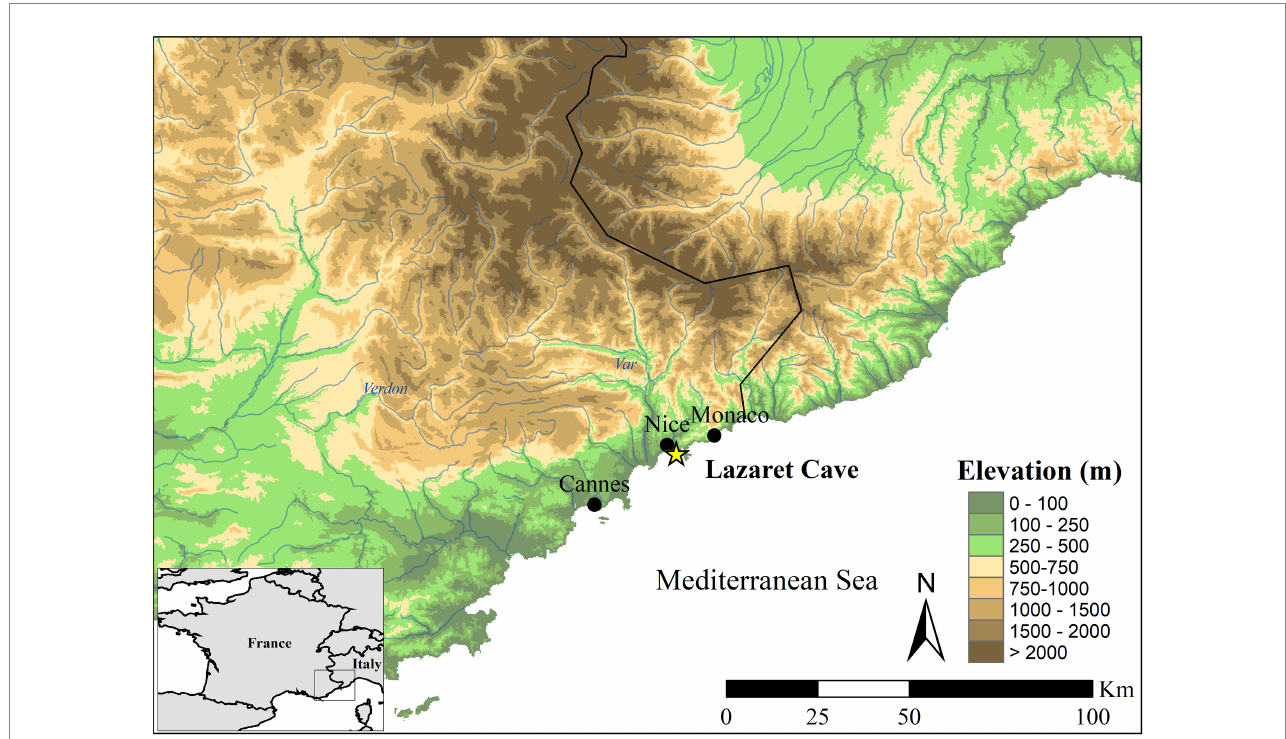
FIGURE 1 Elevation map of selected research area covered by the 87 Sr/ 86 Sr isoscape around Lazaret Cave (43 ° 41 ′ 25 ″ N, 7 ° 17 ′ 42 ″ E). Lazaret is indicated by a yellow star while modern cities are denoted by black circles (Elevation data source: Esri,